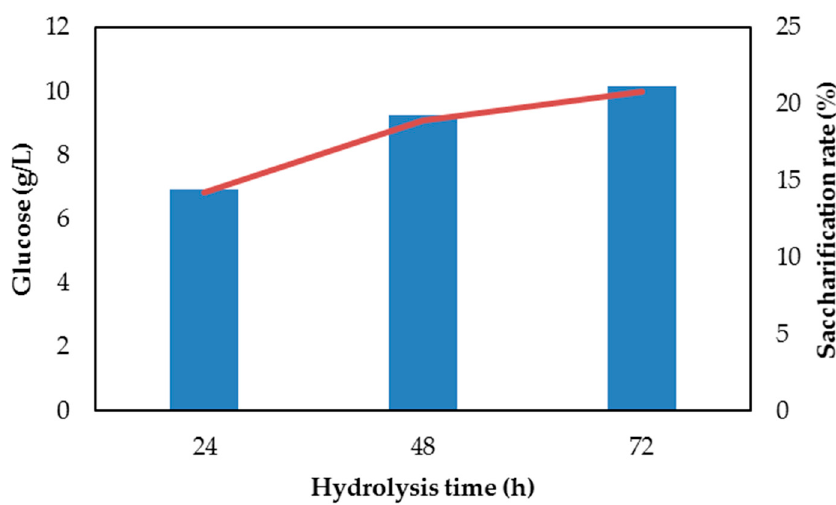
Figure 1. Glucose release (line) and saccharification rate (bars) during 72 h enzymatic hydrolysis of alkaline (NaOH) pretreated beech wood solids. Number of independent experiments: 3. Standard error: 5%.